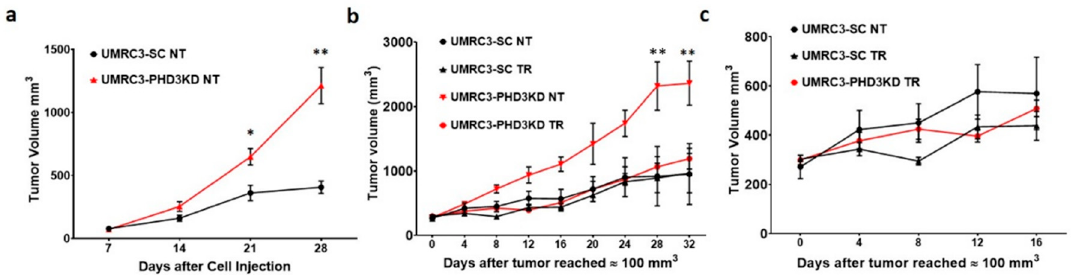
Figure 3. UMRC3-PHD3KD tumors grow more rapidly than UMRC3-SC tumors. ( a ) UMRC3-PHD3KD tumors were significantly larger than UMRC3-SC control tumors at 21 days (* p < 0.02) and 28 days (** p < 0.0005) after cell injection. ( b ) Untreated UMRC3-PHD3KD tumors (NT) were significantly larger than sunitinib-treated UMRC3-PHD3KD tumors (TR) throughout the experiment with the greatest significance between cohorts observed 28 and 32 days post-treatment (** p < 0.0001). ( c ) A replotting of the growth curves for UMRC3-SC NT, UMRC3-SC TR and UMRC3-PHD3KD TR tumors to observe the change in tumor size between UMRC3-SC NT and UMRC3-SC TR cohorts. The combination of sunitinib treatment and PHD3 knockdown resulted in a larger size reduction in UMRC3 tumors relative to sunitinib treatment alone. This was readily observable in the size difference of treated versus untreated UMRC-PHD3KD and UMRC-SC tumors at 12 and 16 days ( p <